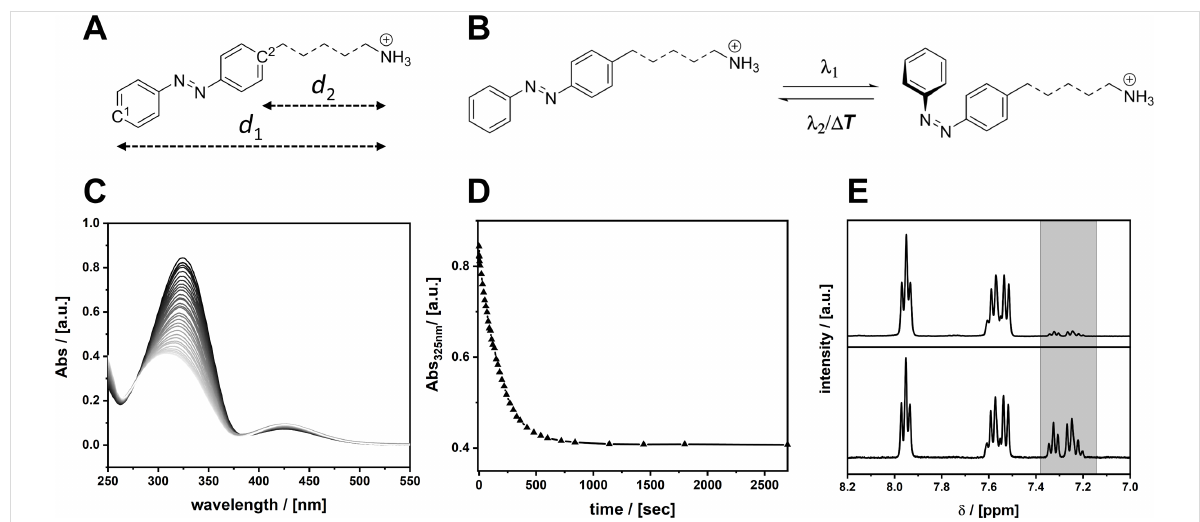
Figure 1: (A) Geometrical description of the azobenzene derivatives used in the current study. (B) Scheme of the photoswitching reaction of the azobenzene ligands under irradiation with UV light ( λ 1 ); a conformational change from trans - to cis -conformation occurs. Blue light ( λ 2 ) or heat ( Δ T ) cause the reverse reaction. (C) UV–vis kinetic measurement of AzoC 2 in purified H 2 O. The solution was irradiated at 313 nm. The black line marks the beginning of the reaction, the light grey lines mark the ending of the reaction. (D) Absorption at 325 nm measured over a time period of 2600 s. (E) 1 H NMR of AzoC 2 in MeOD from 8.0 to 7.2 ppm, before (top) and after irradiation (bottom) at 313 nm for 4 h. Highlighted in grey is the signal of the cis -isomer. Measurements of the other ligands can be found in Supporting Information File 1, Figures S10–S12.